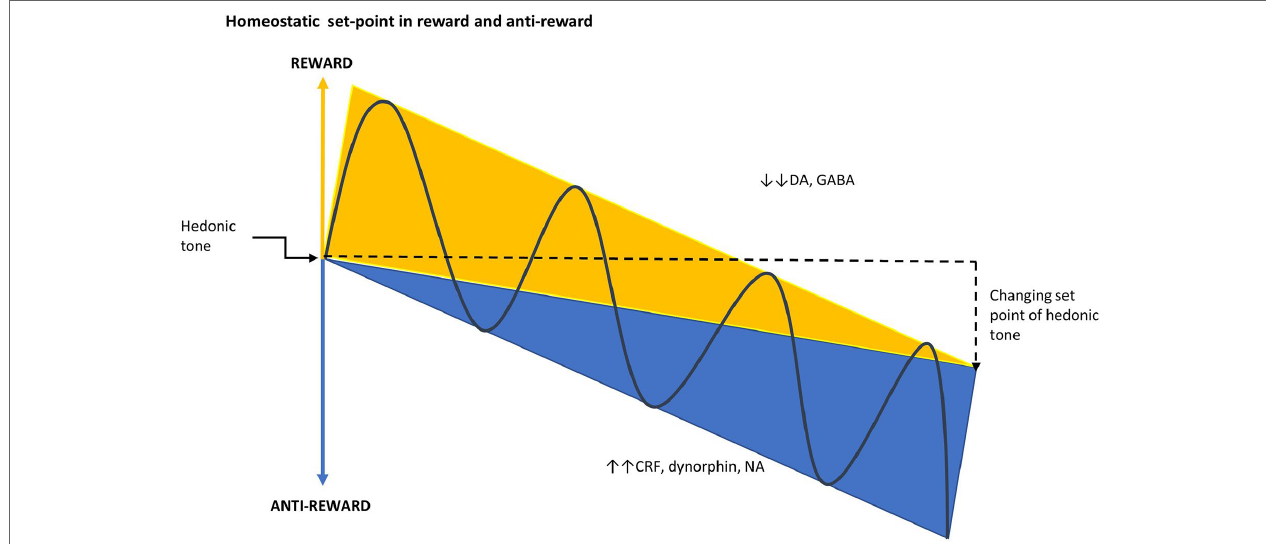
FIGURE 3 | Homeostatic set-point in reward and anti-reward. The set-point of hedonic tone is determined by the balance between the opposing reward and anti-reward pathways. As addiction develops, there is a change in hedonic tone resulting from the deviation of the set-point that occurs when the reward system is down-regulated and the anti-reward system becomes dominant (25). CRF, corticotropin-releasing factor; DA, dopamine; GABA, γ -aminobutyric acid; NA, noradrenaline.